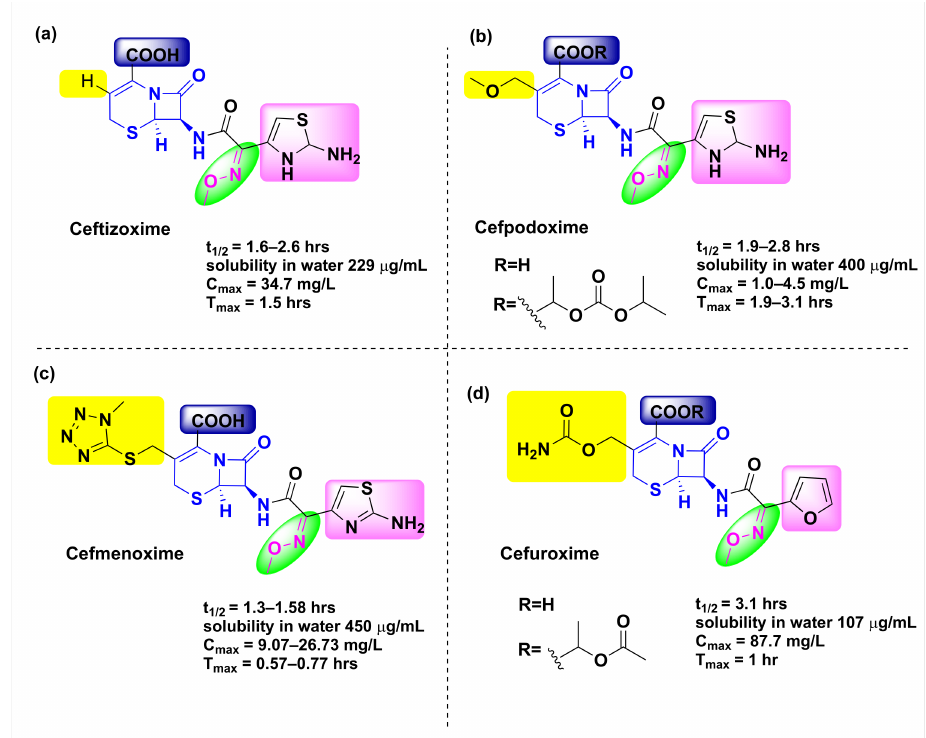
Figure 12. Pharmacokinetic parameters for ( a ) ceftizoxime, ( b ) cefpodoxime, ( c ) cefmenoxime, and ( d ) cefuroxime